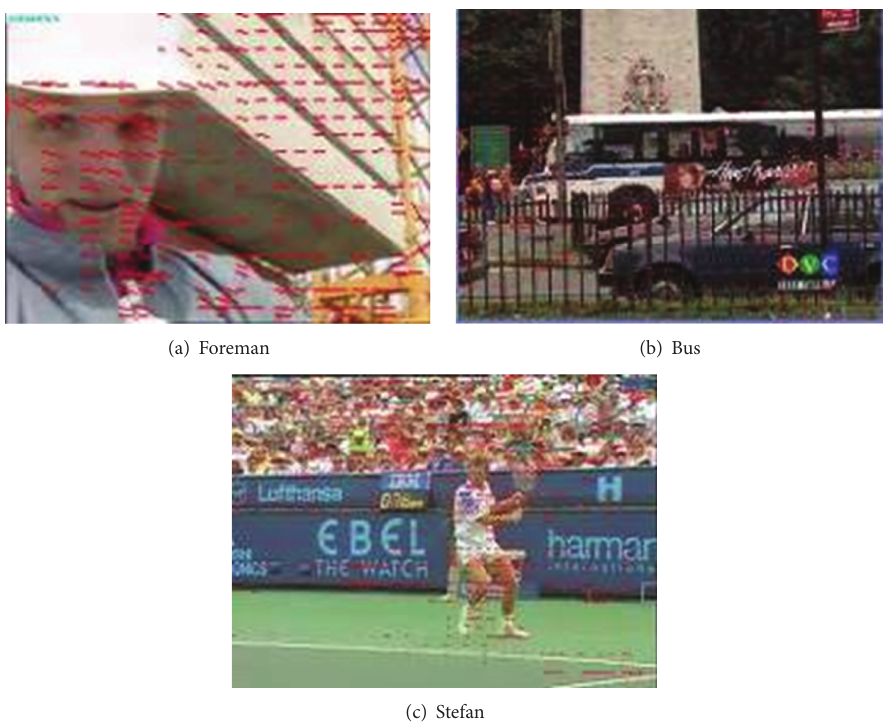
Figure 4: MV distribution in translation background video